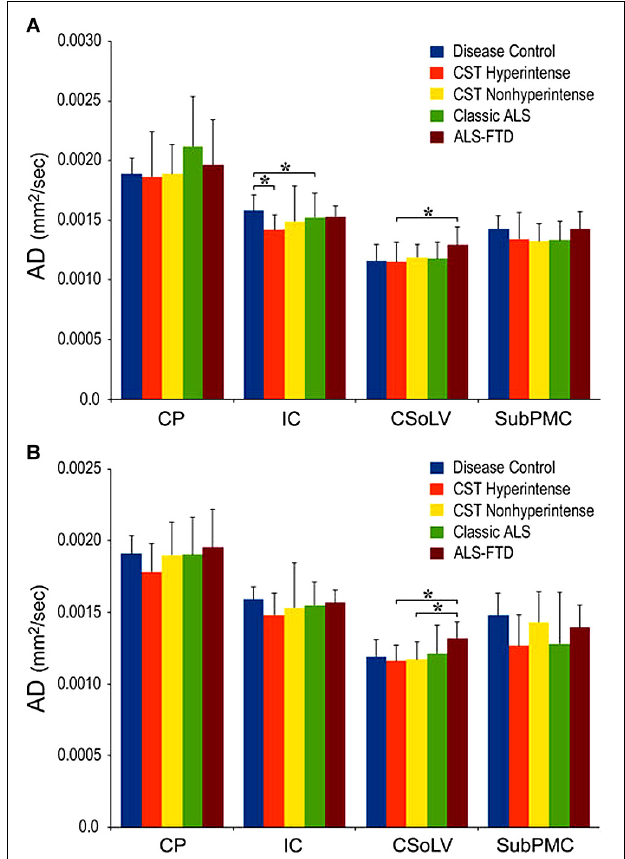
FIGURE 4 | Mean diffusivity (MD) values at four CST levels in left (A) and right (B) hemispheres of ALS patients compared to controls showing significant differences as ∗ P < 0.05. CP, cerebral peduncle; IC, posterior limb of internal capsule; CSoLV, centrum semiovale at top of lateral ventricle; subPMC, subjacent to primary motor cortex. Reproduced with permission from Springer